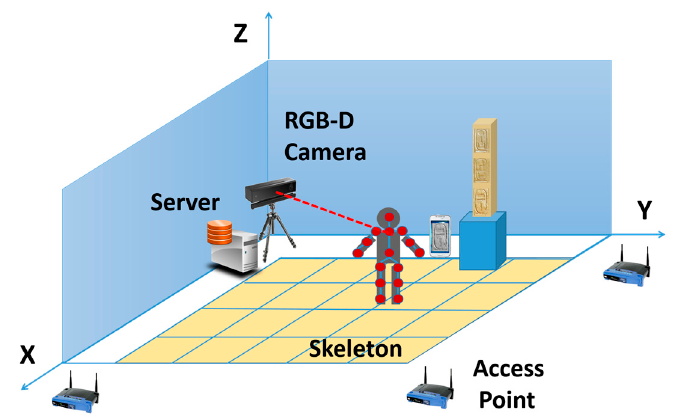
Figure 15. Components of the system.